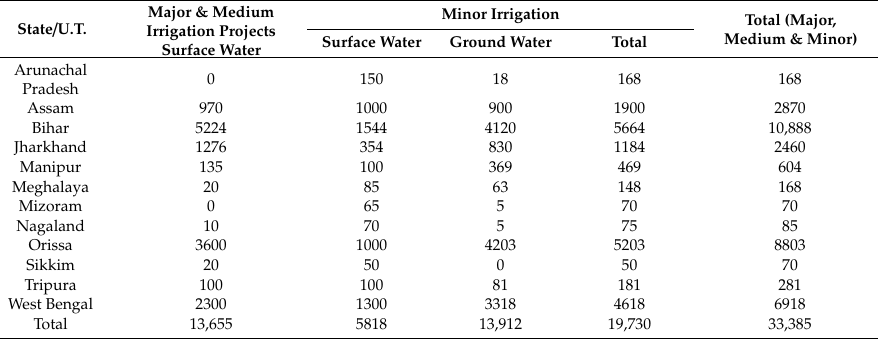
State/U.T. Table 1. Eastern India state-wise irrigation potential (’000 hectares). State /